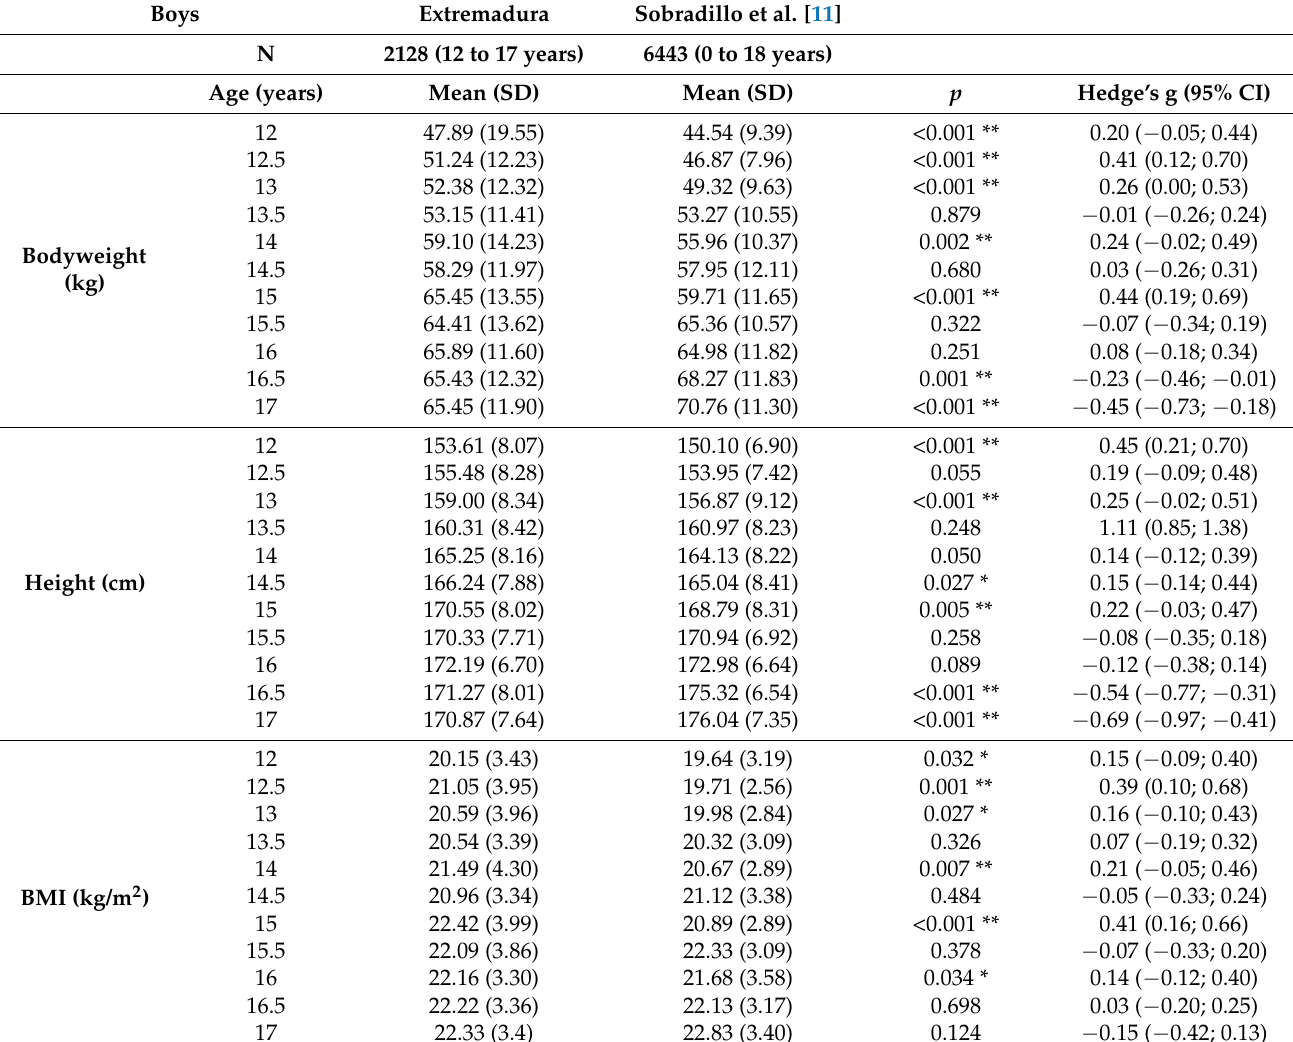
Table 2. Between-study comparison for bodyweight, height and BMI in boys.